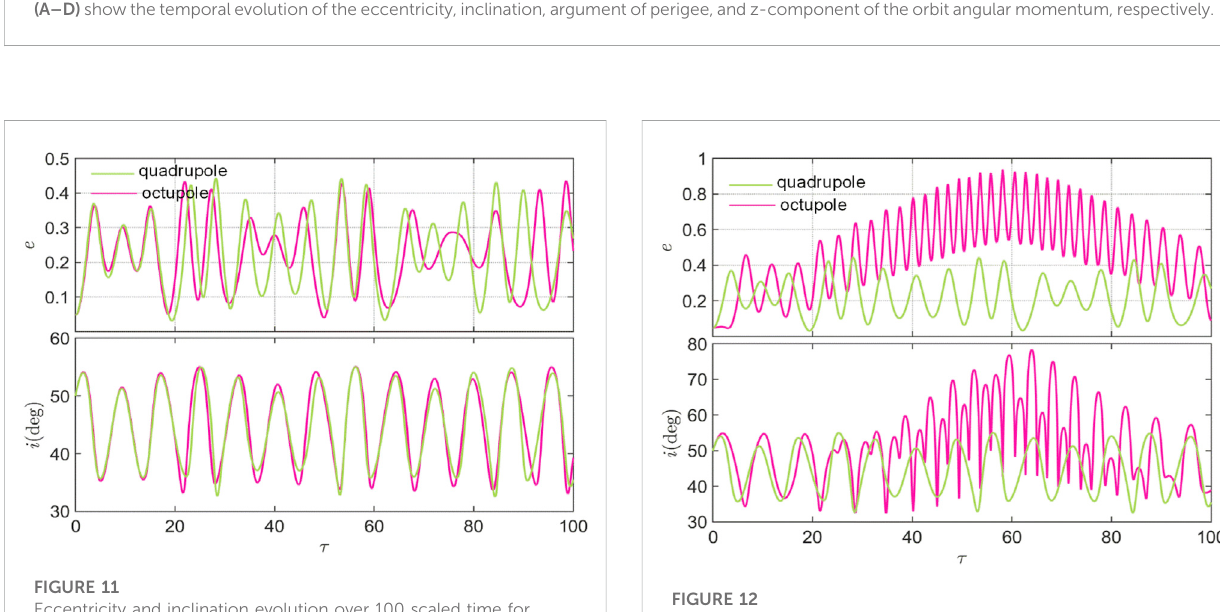
(cid:2) 0, the quadrupole- and octupole-level models are identical. The panels Oct